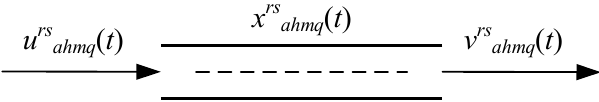
Figure 2. Flow variables for link a .